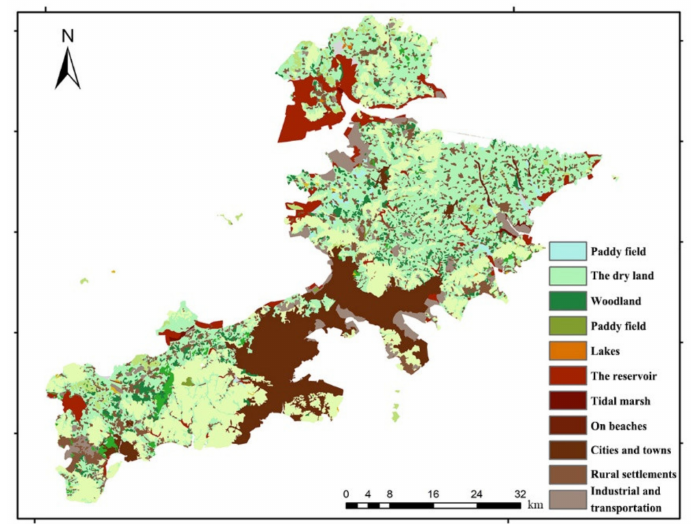
Figure 19. Land classification data of Dalian urban